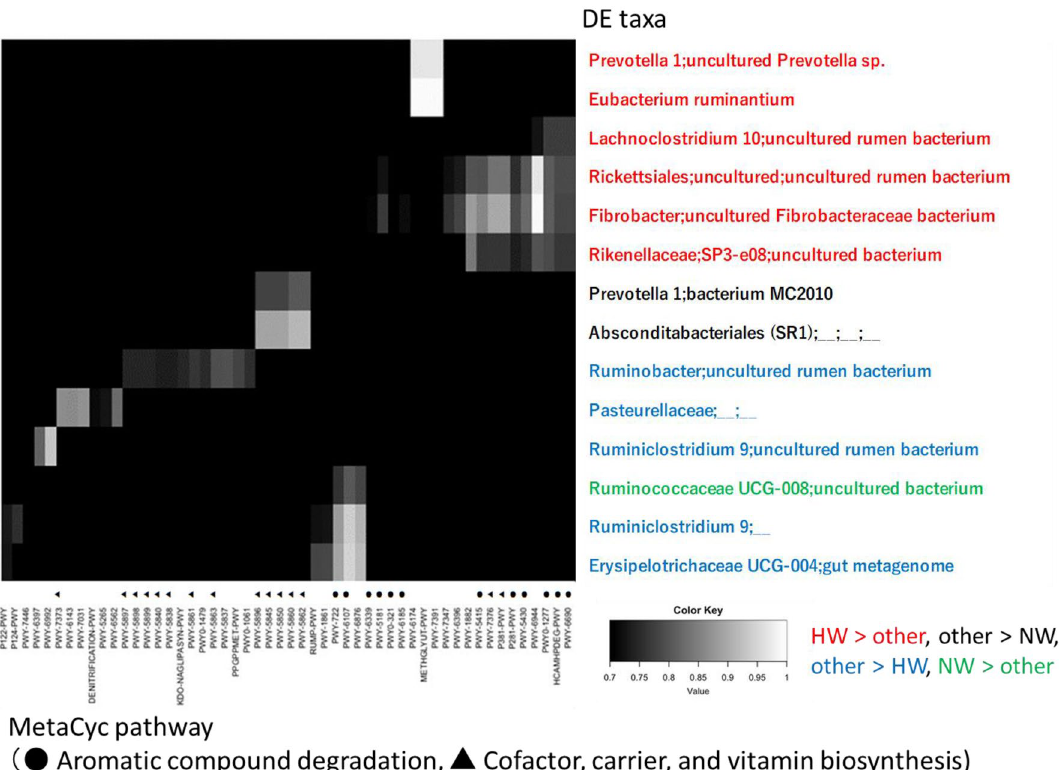
Figure 11. Pearson correlation coefficients between the results of 16S rRNA amplicon-seq and PICRUSt2 in the ruminal bacterial composition. The taxonomy_7_levels.txt file in the SILVA database was used for annotation of bacterial OTUs in the amplicon-seq data. The color of the DE taxa indicates a statistically significant difference among the groups (q < 0.01) analyzed by TCC baySeq. PICRUSt2 analysis was performed with dada2 output in QIIME2. The MetaCyc pathway was searched in the PICRUSt2 pipeline. Correlations with a coefficient between 0.7 and 1.0 are shown. Aromatic compound degradation and cofactor, carrier, and vitamin biosynthesis are shown as filled circles and triangles,